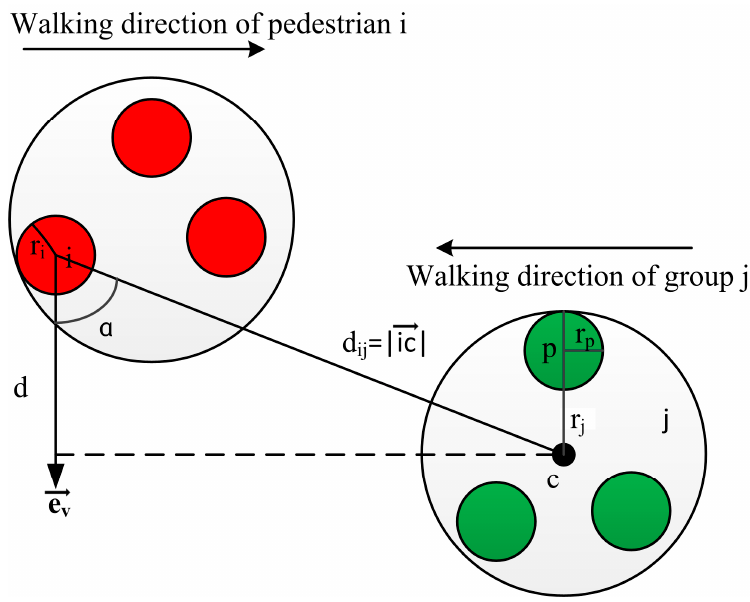
Figure 1. Illustration of group holistic avoiding behavior. Pedestrian i and group j are walking in the opposite direction with the distance d in (cid:2187) (cid:2204) (cid:4652)(cid:4652)(cid:4652)(cid:4652)(cid:1318) . e v